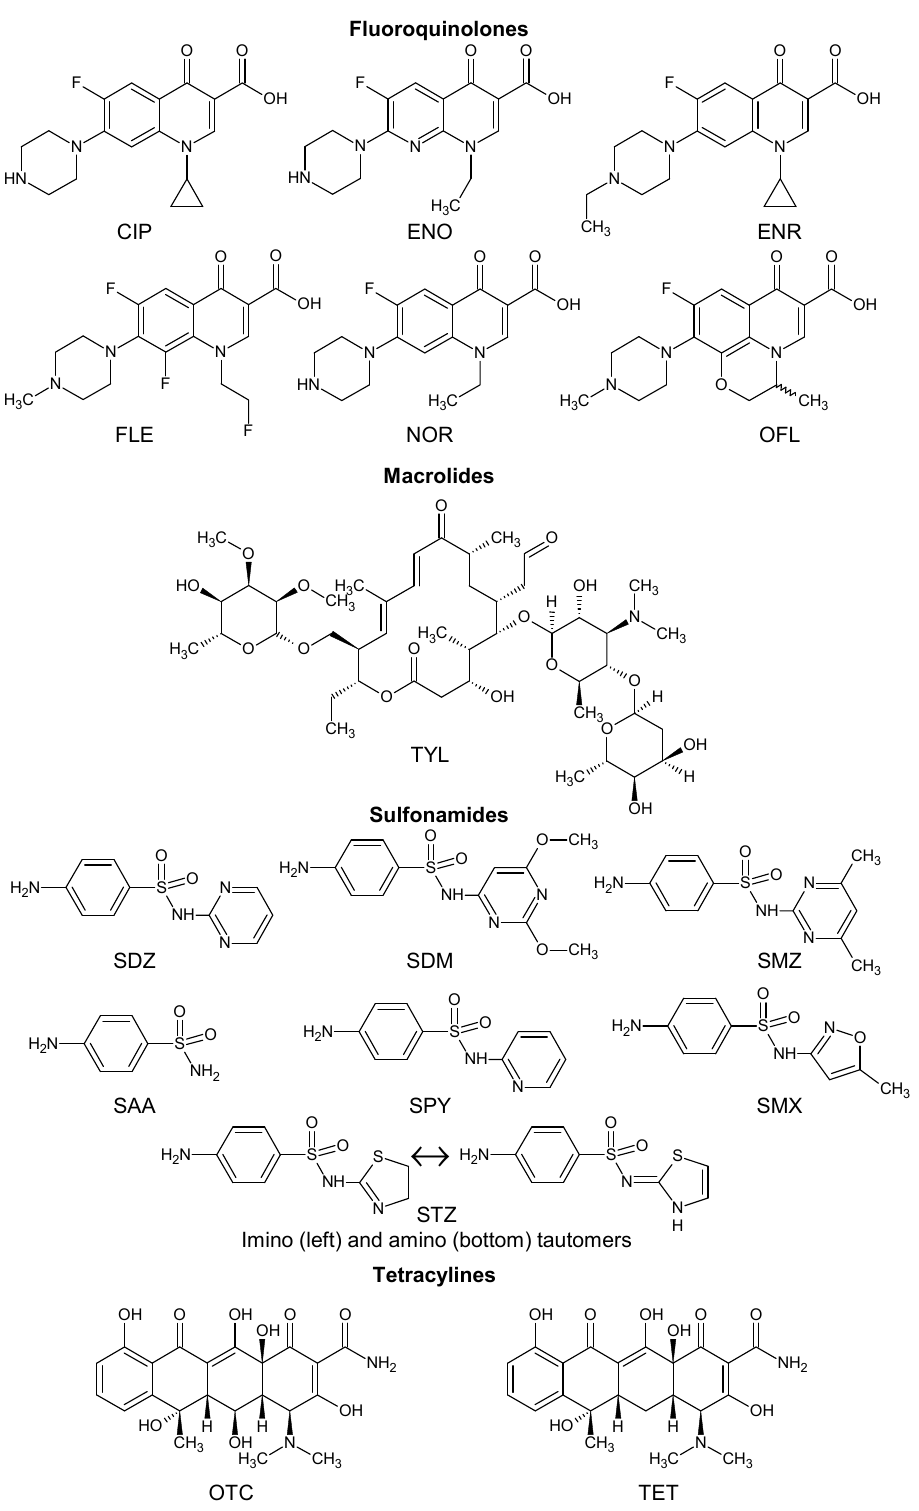
Figure 1. Skeletal formulas of the selected antibiotics considered in this review. FQ: ciprofloxacin (CIP); enoxacin (ENO); enrofloxacin (ENR); fleroxacin (FLE); norfloxacin (NOR); ofloxacin (OFL). MA: tylosin (TYL). SU: sulfadiazine (SDZ); sulfadimethoxine (SDM); sulfamethazine (SMZ); sul- famethoxazole (SMX); sulfanilamide (SAA); sulfapyridine (SPY); sulfathiazole (STZ). TE: oxytet- racycline (OTC); tetracycline (TET).